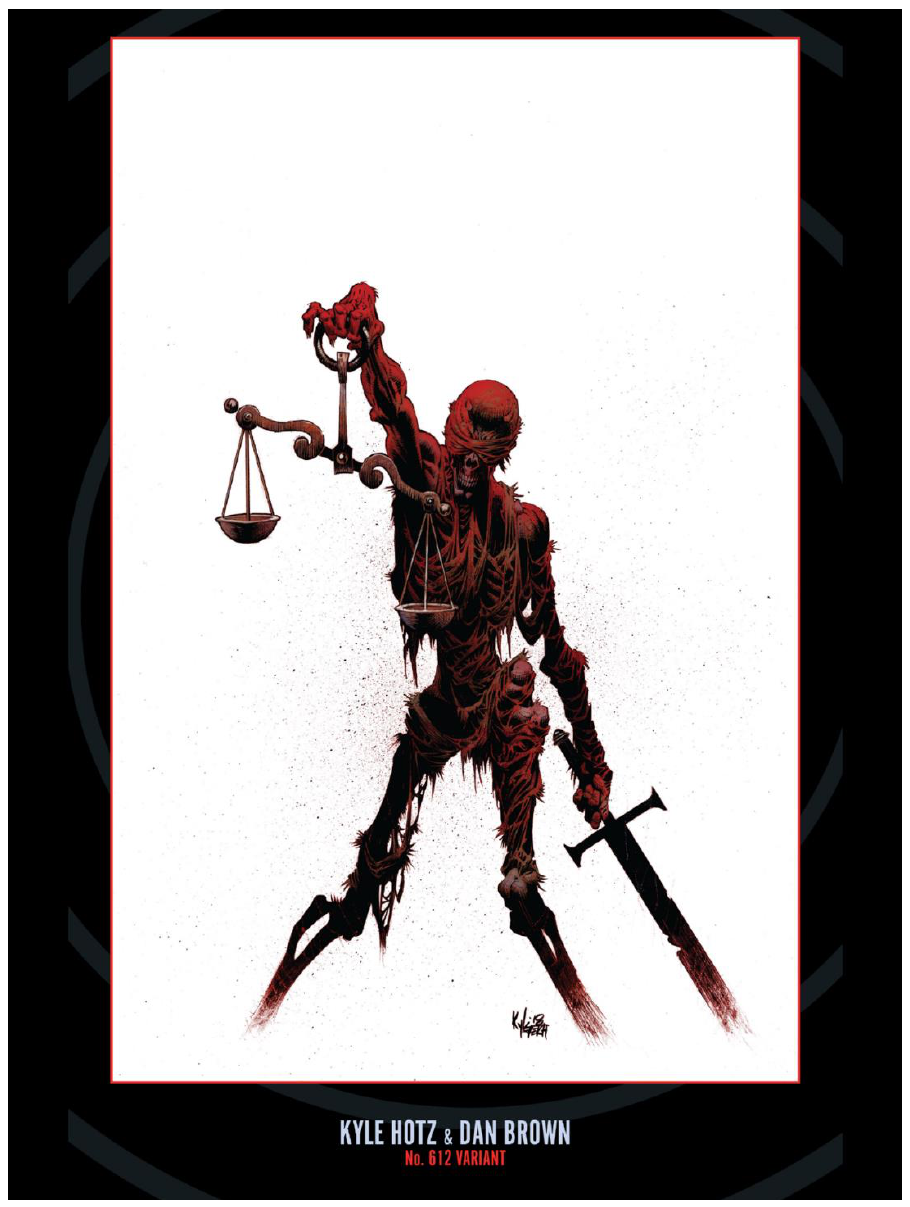
Figure 3. Alternate Cover Art for Soule Daredevil: Back in Black Vol. 8: Death of Daredevil #612, 2018 Image Credit: Kyle Hotz and Dan Brown © 2019